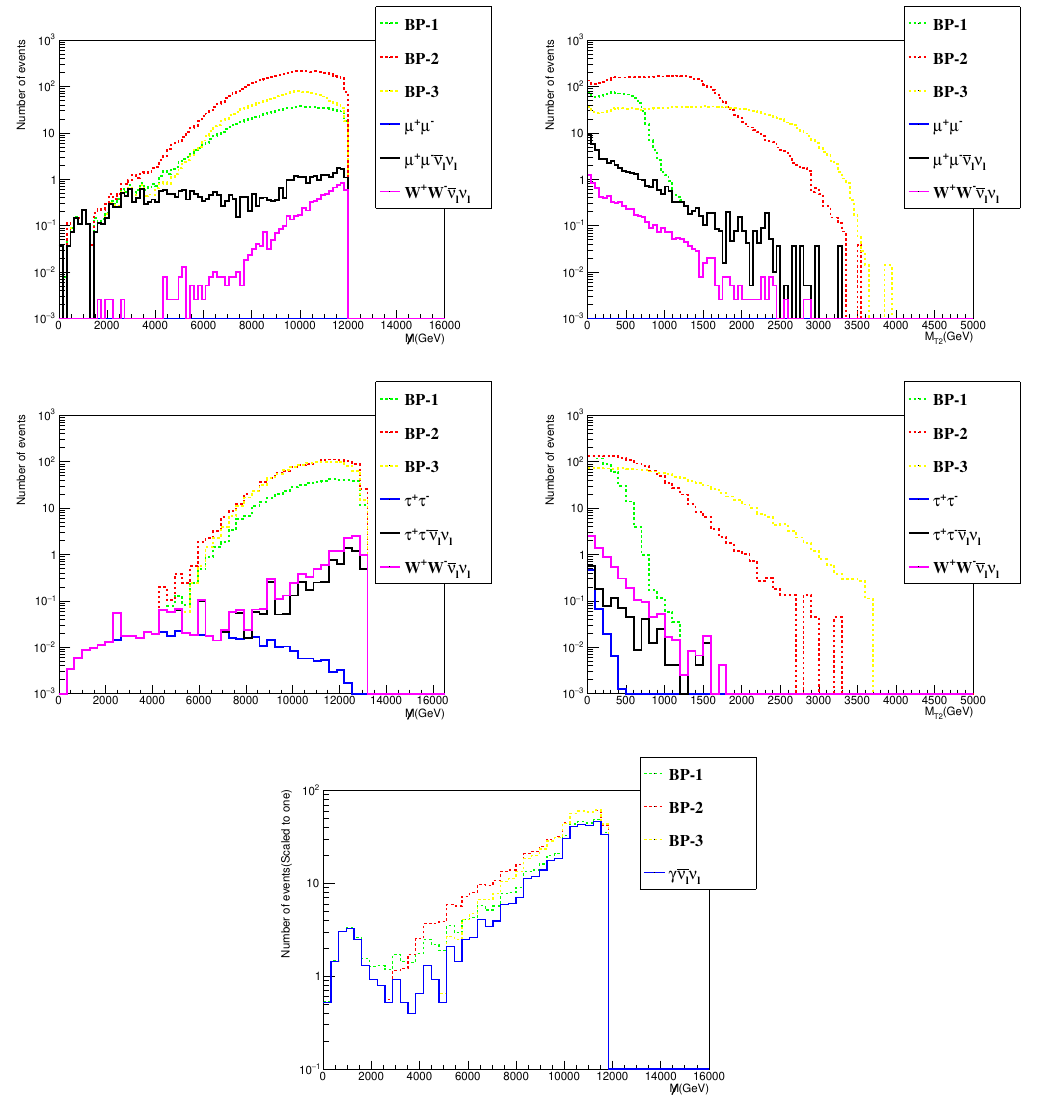
Figure 15 . Events number of (cid:26)(cid:26) M and M T 2 in the dilepton and mono-photon signature after applying all cuts with 200 fb − 1